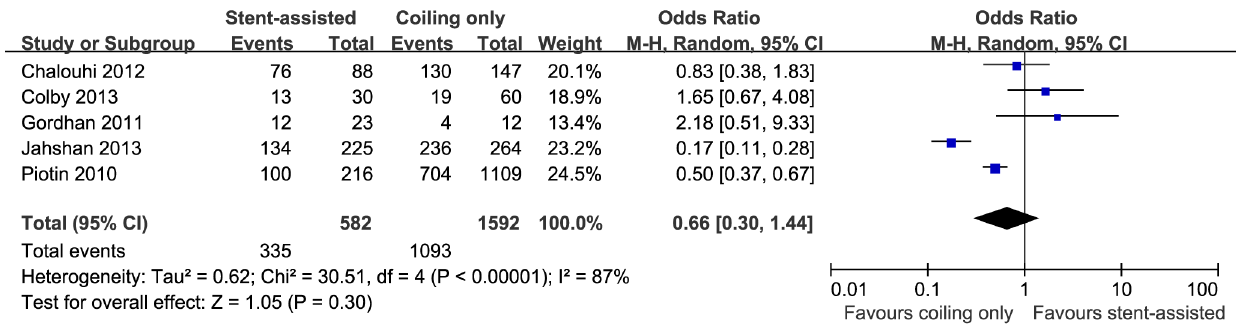
Figure 2. Forest plot of immediate occlusion rate comparing stent-assisted coiling versus coiling only. Random-effect model was applied.